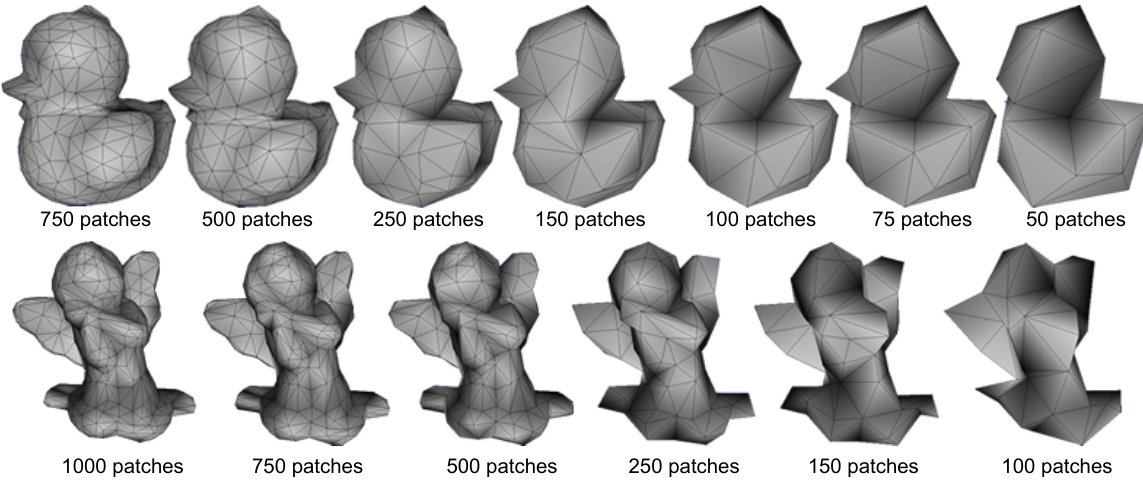
Fig. 13. Polygonal meshes used in the experiments of the duck and the angel objects: when the remeshing is overdone, accuracy of CT becomes lower because of changes in the original shape of the